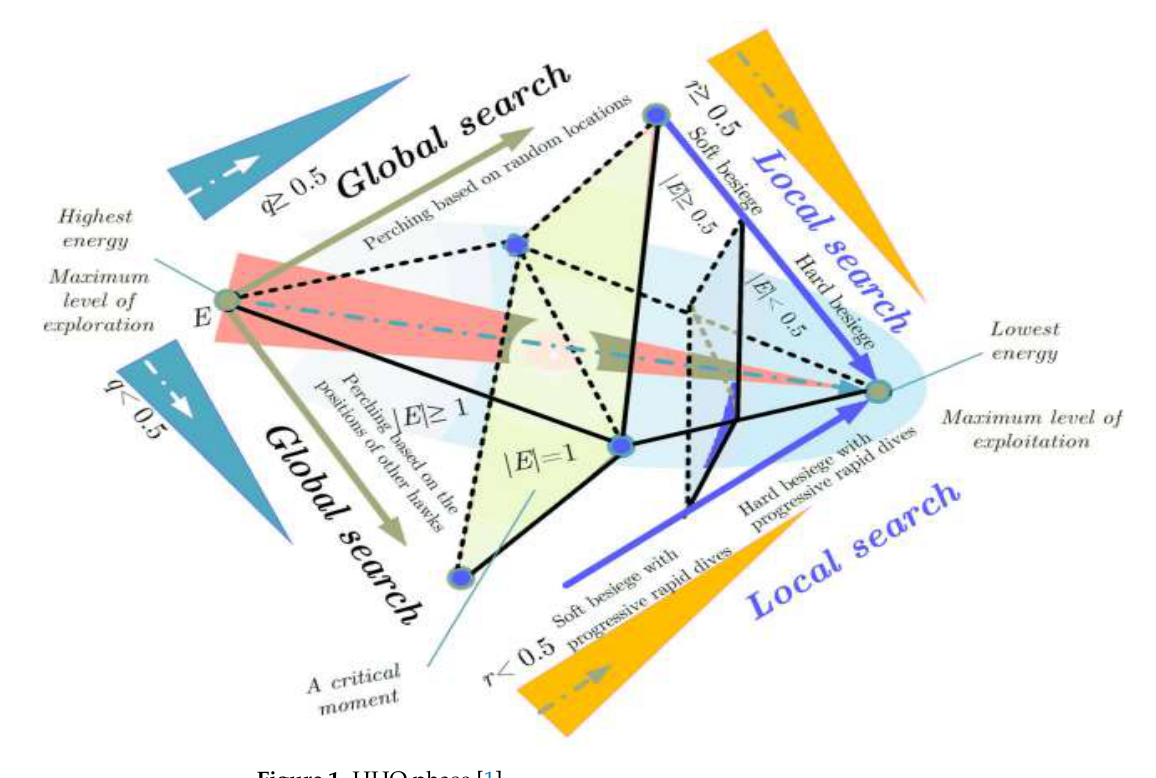
Figure 1. HHO phase [1].